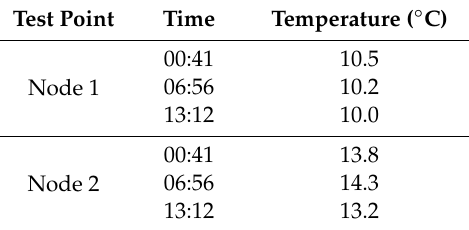
Figure 12. Information sent by GPRS. Table 6. Temperature data